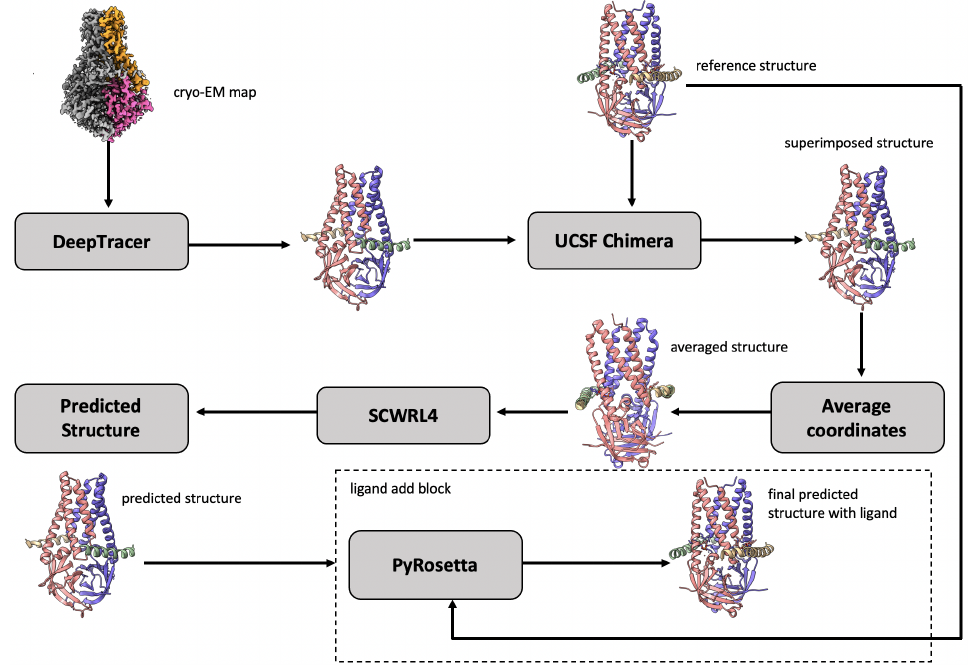
Figure 2. The workflow of DeepProLigand generating protein complex structure from cryo-EM map and reference structure. The cryo-EM map (EMD-22898) illustrated in the workflow is of a SARS-CoV-2 ORF3a ion channel in lipid nanodiscs